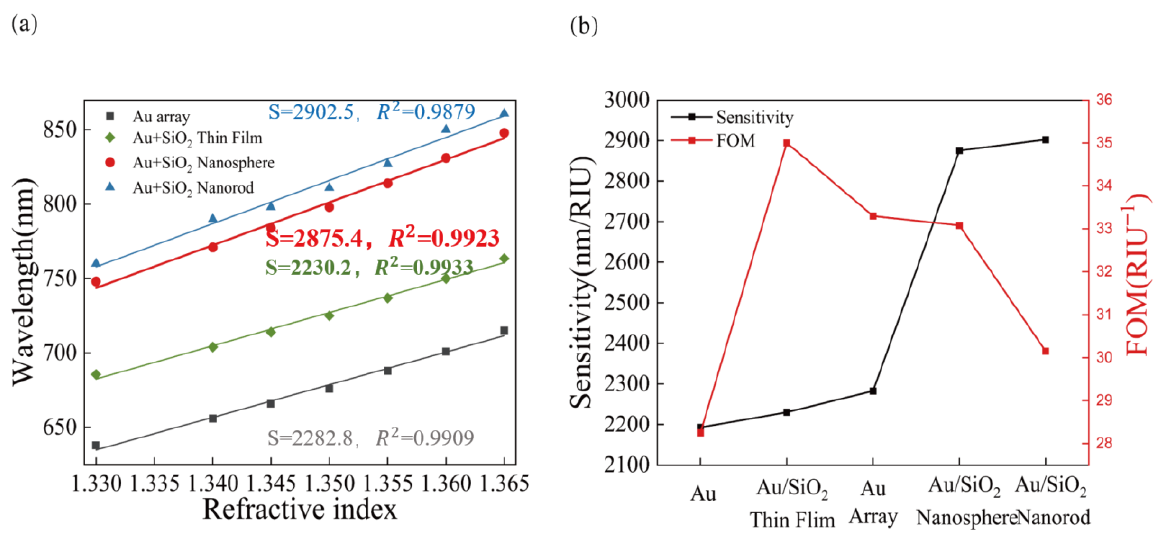
Figure 12. Comparison of the sensitivity of the five structures, ( a ) comparison of sensitivity and ( b ) comparison of the sensitivity and FOM . Table 5. Performance comparison of the different SPR